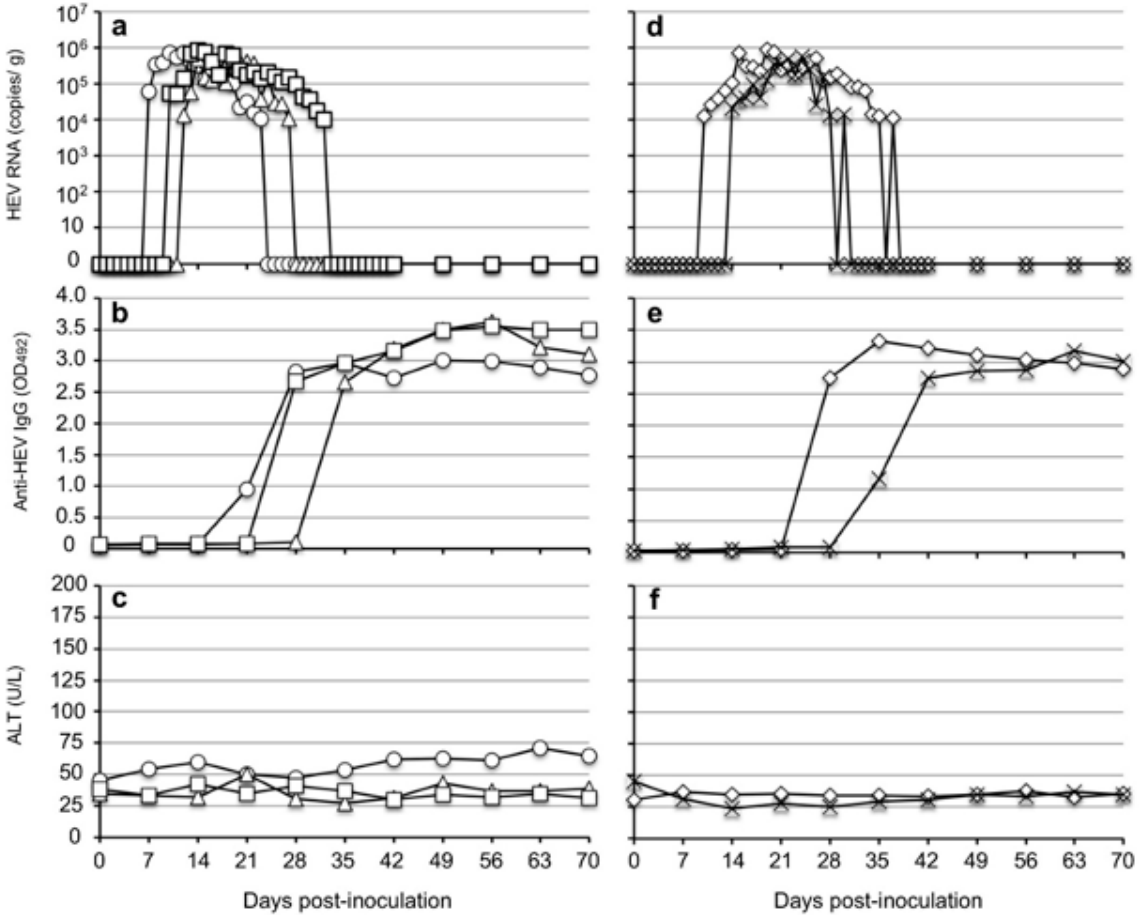
Figure 3. Infectivity of rat HEV in rhesus monkeys. Five rhesus monkeys were separated into two groups. Three monkeys, M097 ( ), M107 ( (cid:52) ), and M117 ( (cid:3) ), were inoculated with 10 7 copies of the rat HEV V-105 strain. Two monkeys, M411 ( ) and M418 ( × ), were inoculated with 10 6 copies of the virus. The kinetics of the viral RNA in the fecal specimens ( a , d ) were determined by RT ‐ qPCR. Anti ‐ rat HEV IgG antibodies ( b , e ) in the sera were determined by ELISA. ALT levels were measured by a commercial kit ( c , f ).